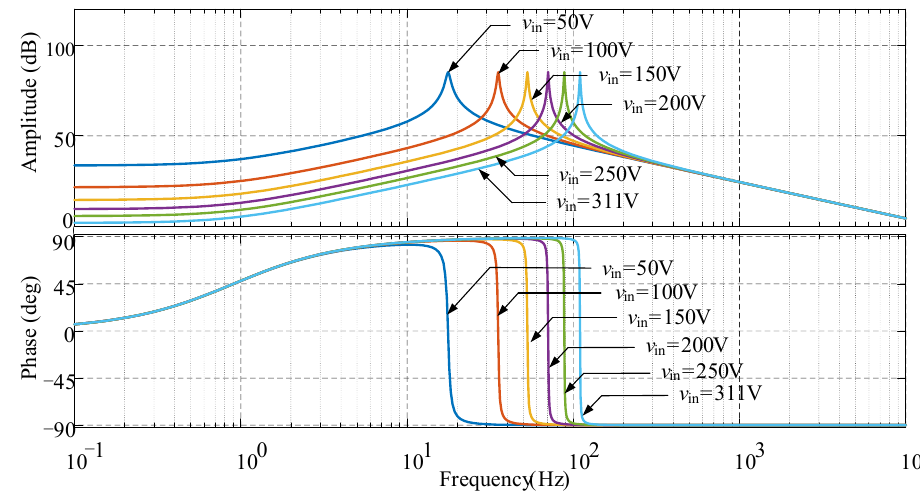
Figure 4. Bode plot of G id (s) at different input voltages.